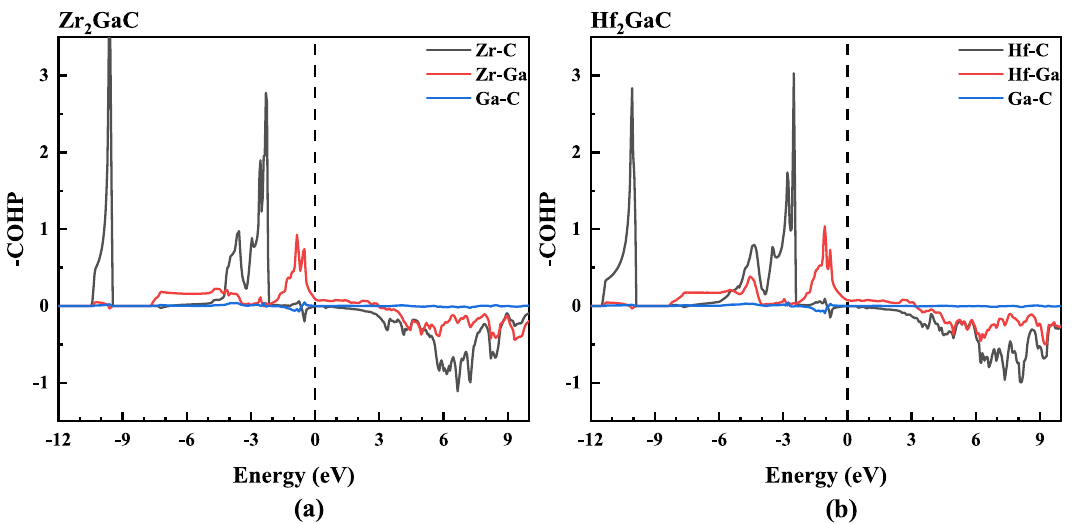
Figure 7. The calculated crystal orbital Hamilton population (COHP) showing the pair interactions of M–C, M–Ga, and Ga–C in a Zr 2 GaC and b Hf 2 GaC. Positive values in the y-axis (–COHP) indicating the bonding states. Fermi level is set to 0